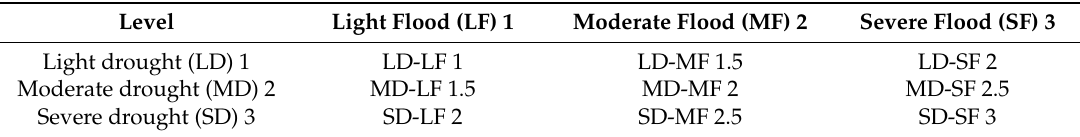
Table 3. The combination types of drought–flood abrupt